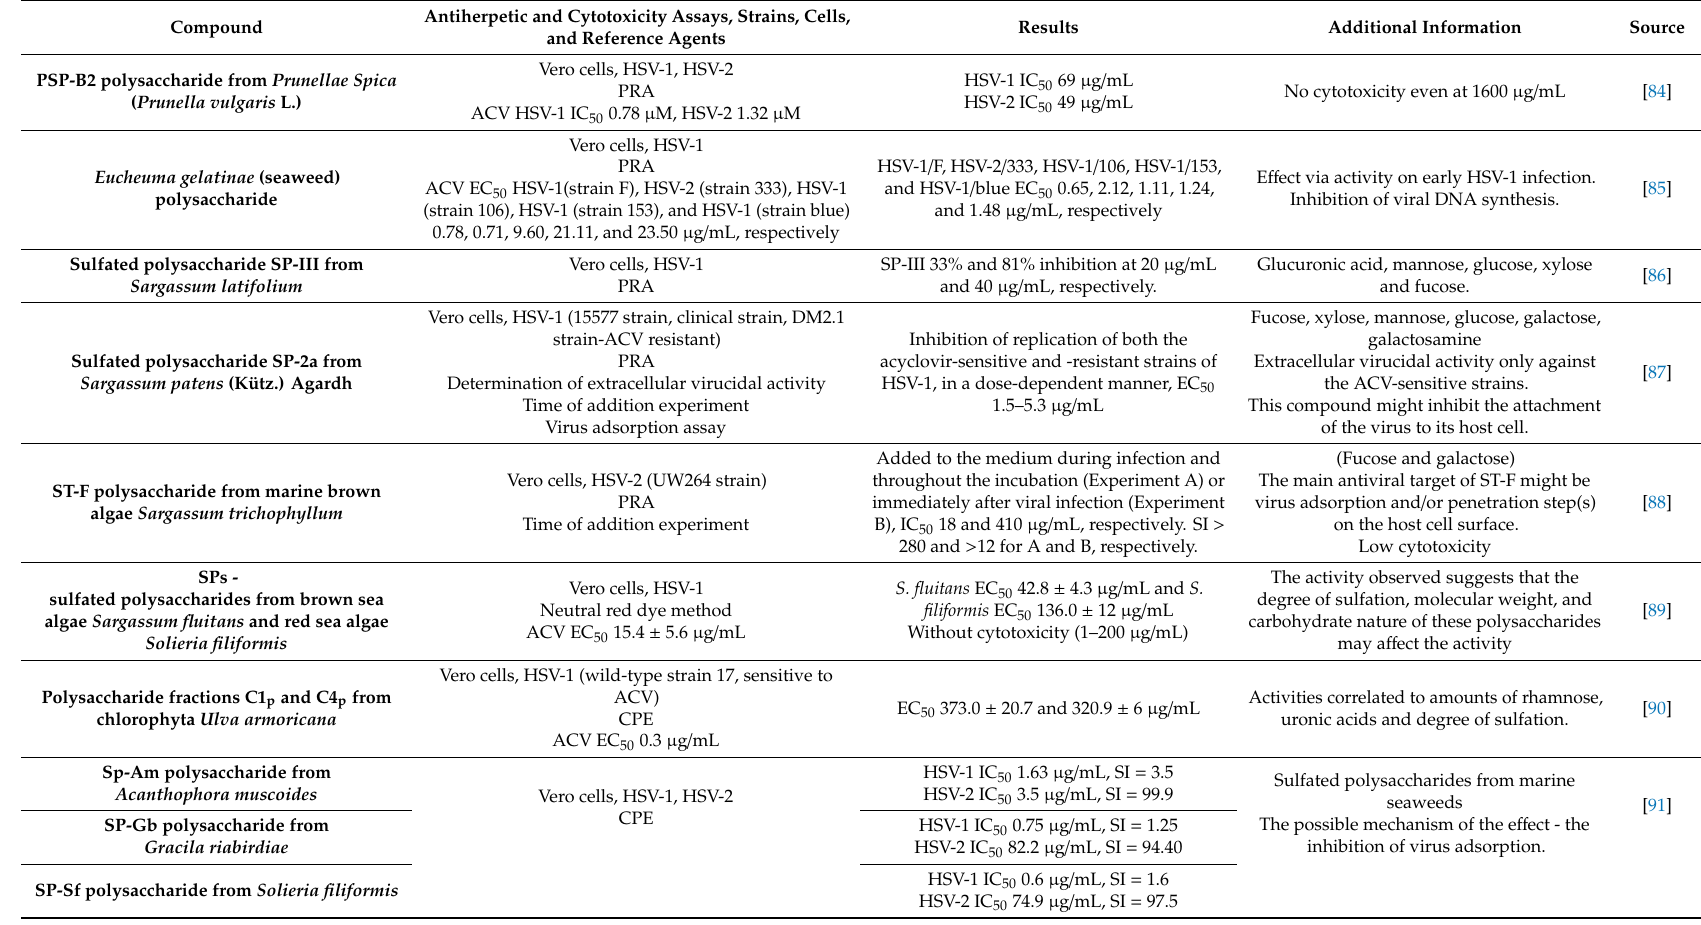
Table 5. The overview of polysaccharides with anti-HSV